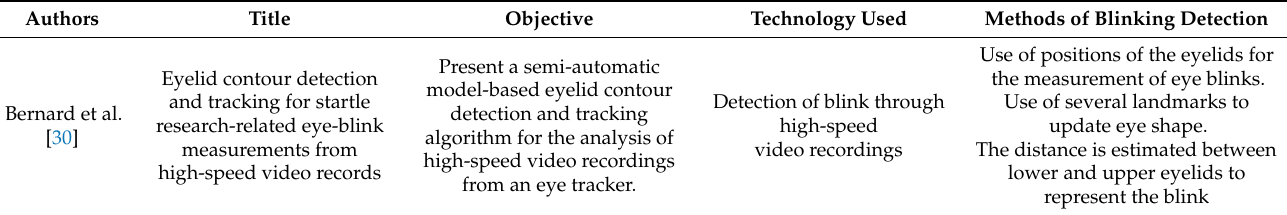
Table 2. Summary of studies that address systems to determine